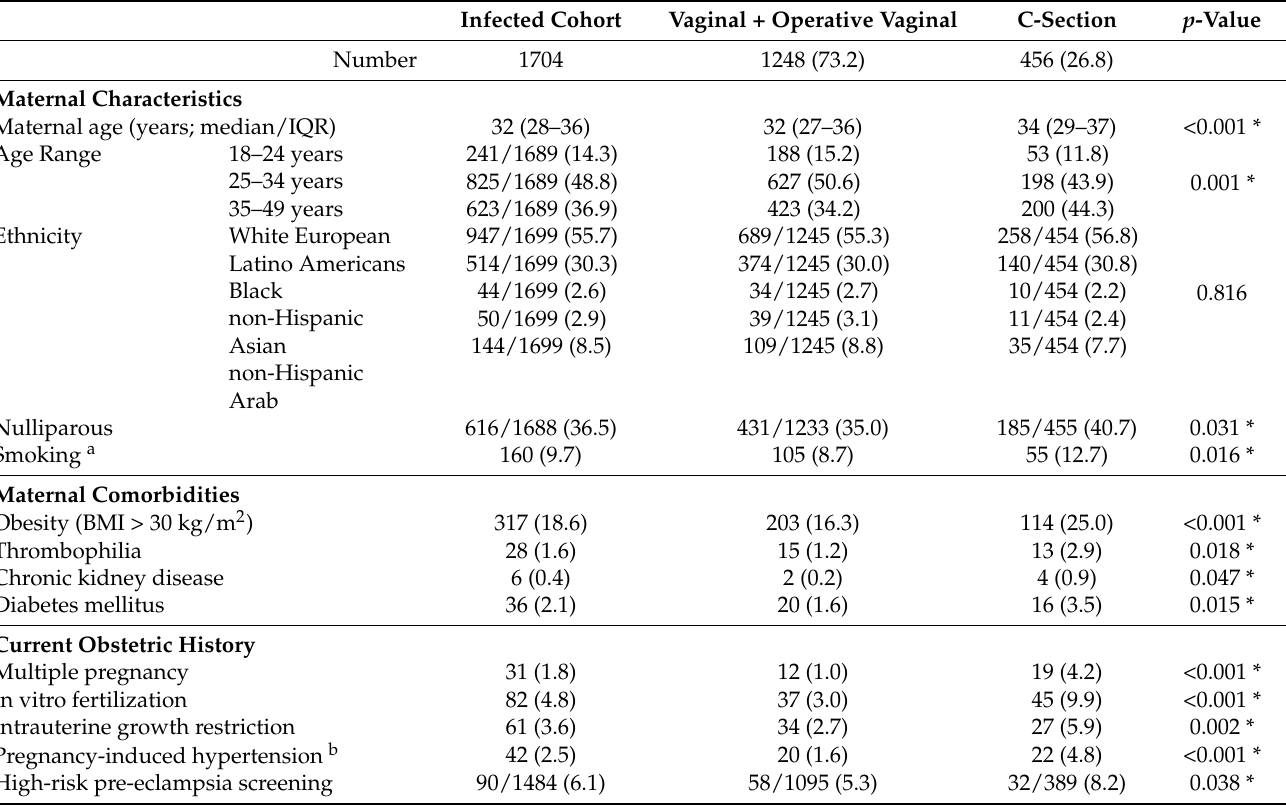
Table 1. Demographic characteristics, comorbidities and current obstetric history of the study participants (n =